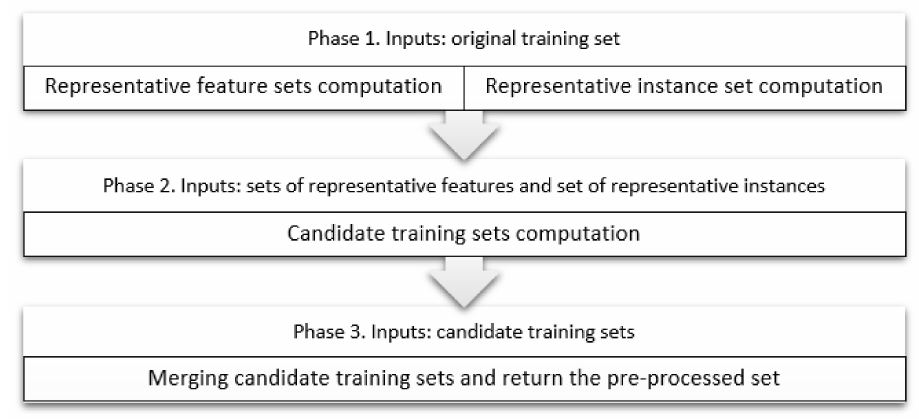
Figure 2. Schematic of the proposed